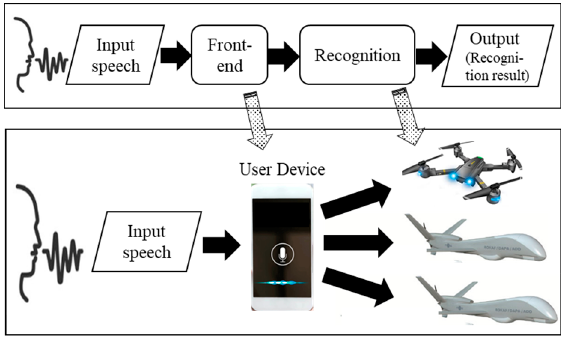
Figure 3. Proposed distributed speech recognition scheme for multi-UAV control.